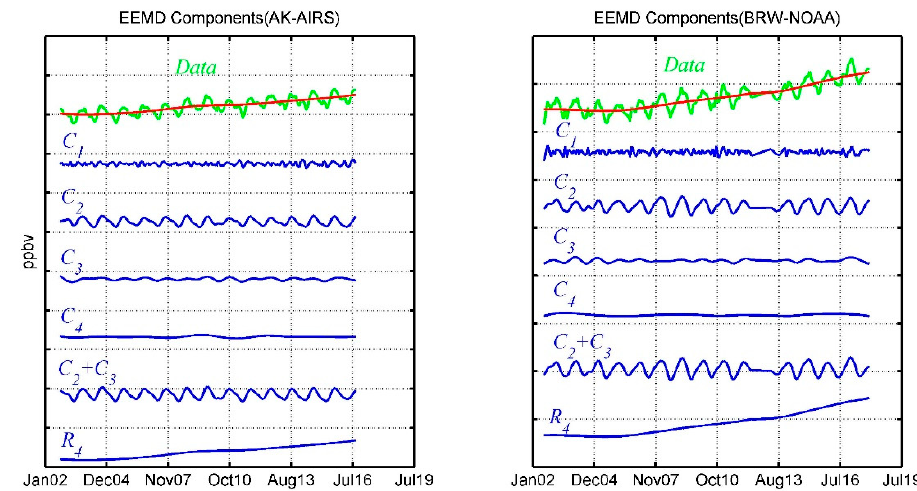
Figure 3. EEMD decomposition of the AIRS CH 4 over the Alaska region (left) and surface CH 4 (right) from the Barrow / NOAA / GMD station. The original data (green line) together with the EEMD trend (red line), four EEMD components ( Cj ), and the remainder R 4 are shown for each region. We also make comparison between MUT and total column-average CH 4 (X ch4 )